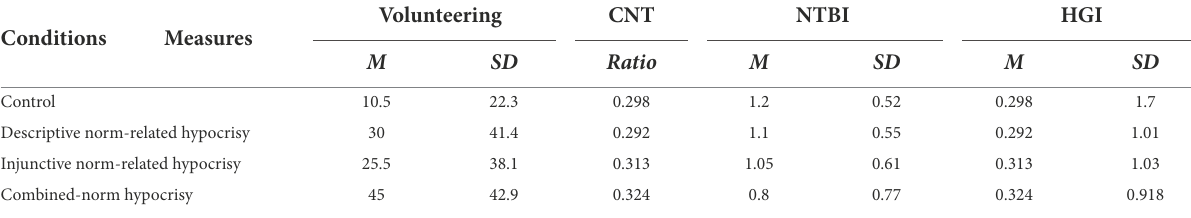
TABLE 1 Means, standard deviations, and ratio for study variables across conditions.